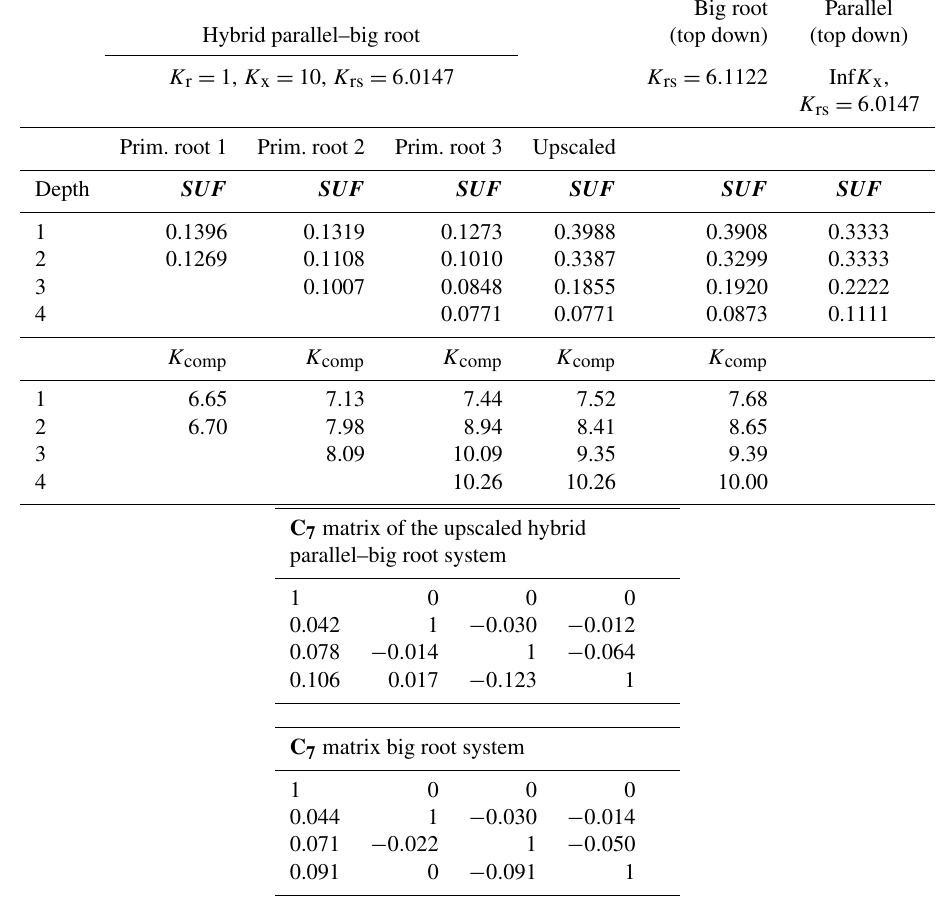
Table 2. K rs , SUF , K comp , and upscaled values and C 7 matrices for the hybrid parallel–big root system with constant K r along the roots, the big root system, and the parallel root system (with infinite K x ) using top-down parameterization. Big root Parallel Hybrid parallel–big root (top down) (top down) K r = 1, K x = 10, K rs = 6 . 0147 K rs = 6 . 1122 Inf K x , K rs = 6 . 0147 Prim. root 1 Prim. root 2 Prim. root 3 Upscaled Depth SUF SUF SUF SUF